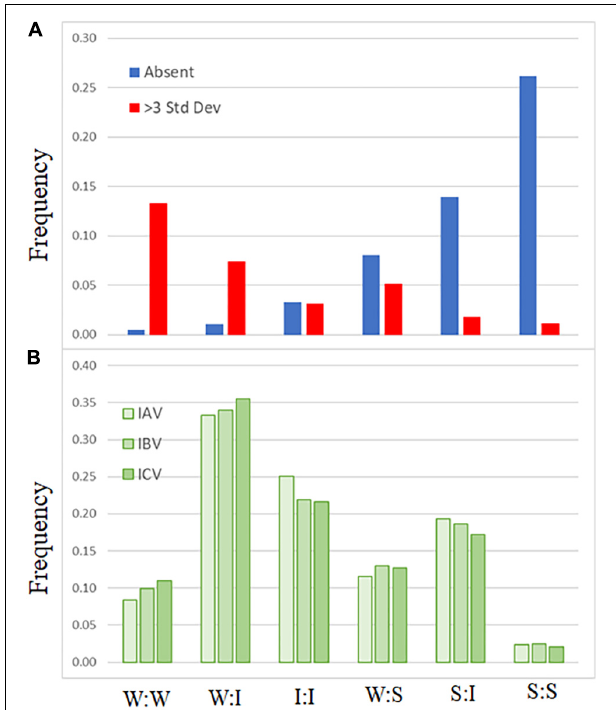
FIGURE 3 | Frequency of influenza codon-pairs grouped by type. Codon-pairs from influenza A, B, and C genomes were grouped by network interaction strength [weak (W), intermediate (I), strong (S); see Figure 1 ]. The frequency of the codon-pairs that were absent or over-represented ( > 3 standard deviations above the mean frequency of all codon-pairs) was calculated for each group (A) . The expected frequency of the codon-pairs was calculated from the codon usage for influenza A, B, and C viruses (B)